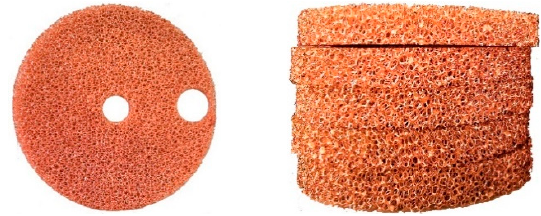
Figure 7. Porous medium: foam